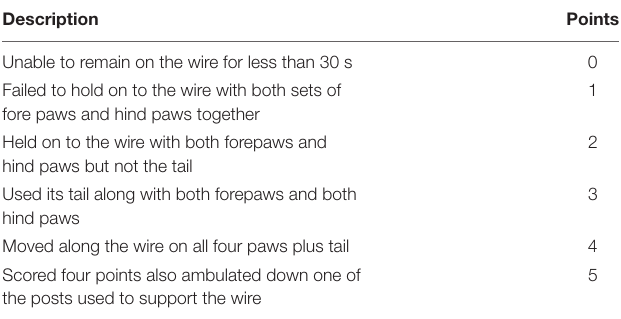
TABLE 2 | Grip test